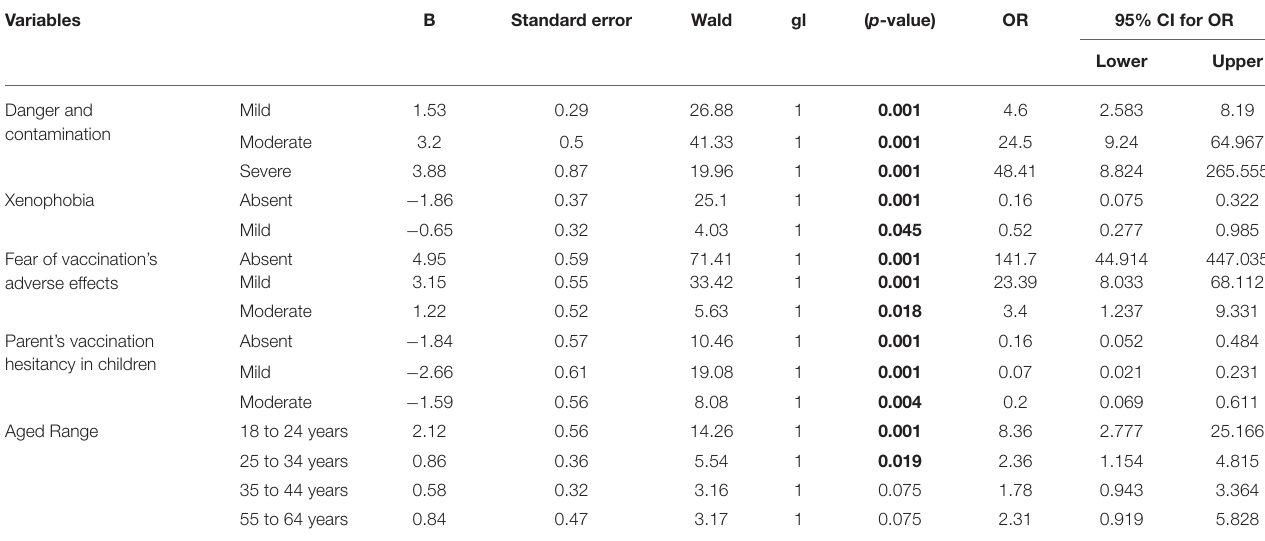
TABLE 5 | Results of binary logistic regression analysis on demographic factors and sections significantly associated with willingness to get vaccinated. Variables B Standard error